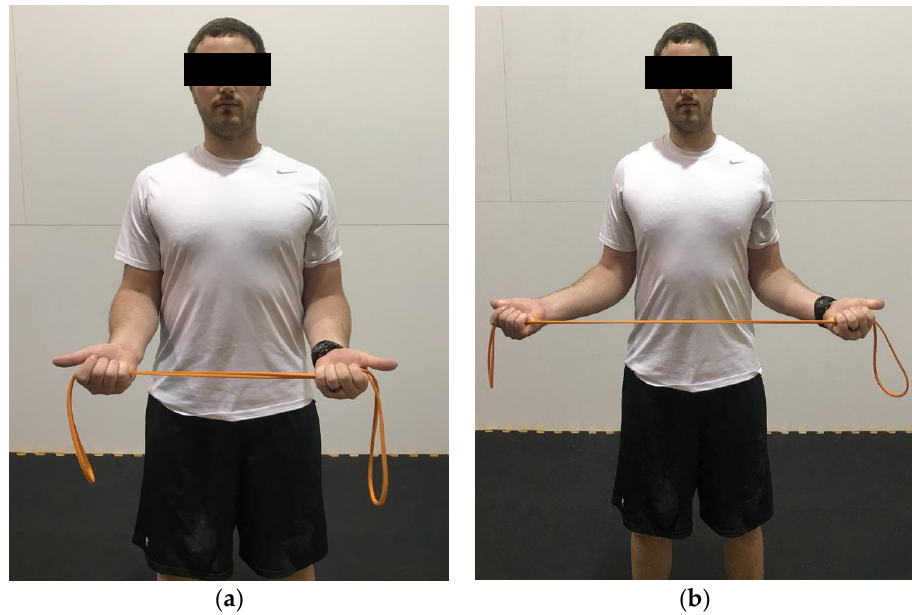
Figure 3. Demonstration of standing external rotation in the ( a ) start position; ( b ) end position. Hands are pronated and elbows are flexed to approximately 90°. Pull the band apart, while focusing on retracting the scapula.